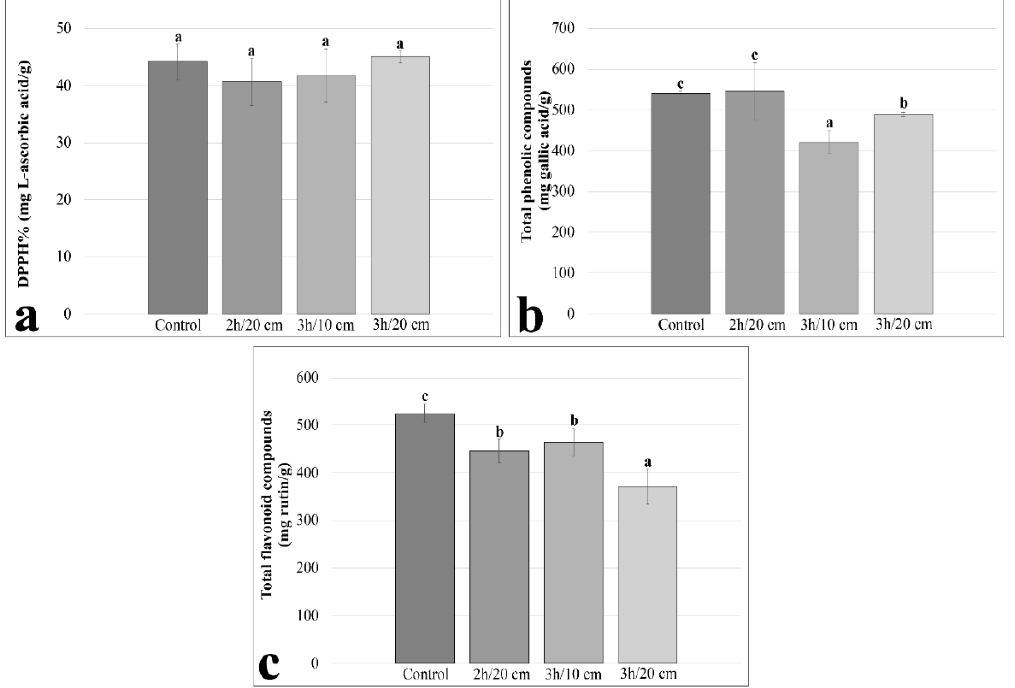
Figure 2. The effects of UV-B radiation on antioxidant activity, total phenolic compounds, and total flavonoid compounds on the groups showing more acute effects caused by exposure to UV-B rays. ( a ) DPPH% activity after 2 h of treatment at 20 cm, 3 h of treatment at 10 cm and 3 h of treatment at 20 cm; ( b ); Total phenolic compounds after 2 h of treatment at 20 cm, 3 h of treatment at 10 cm and 3 h of treatment at 20 cm; ( c ) Total flavonoid compounds after 2 h of treatment at 20 cm, 3 h of treatment at 10 cm and 3 h of treatment at 20 cm. Different letters within the figures indicate statistically significant differences.